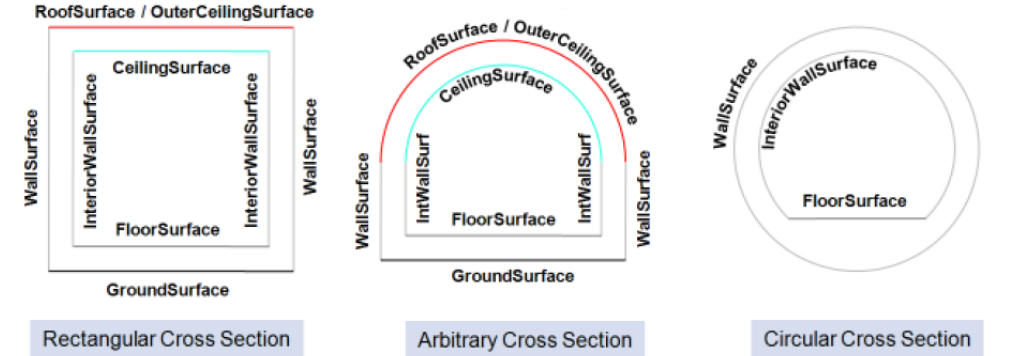
Figure 3. Examples of semantic objects for boundary surfaces in tunnels. In LoD2-4 only the outer surfaces (WallSurface, RoofSurface, GroundSurface, OuterCeilingSurface and OuterFloorSurface) are available while the interior surfaces (InteriorWallSurface, FloorSurface and CeilingSurface) may only be used in LoD 4 (Excerpt from (Gröger et al.